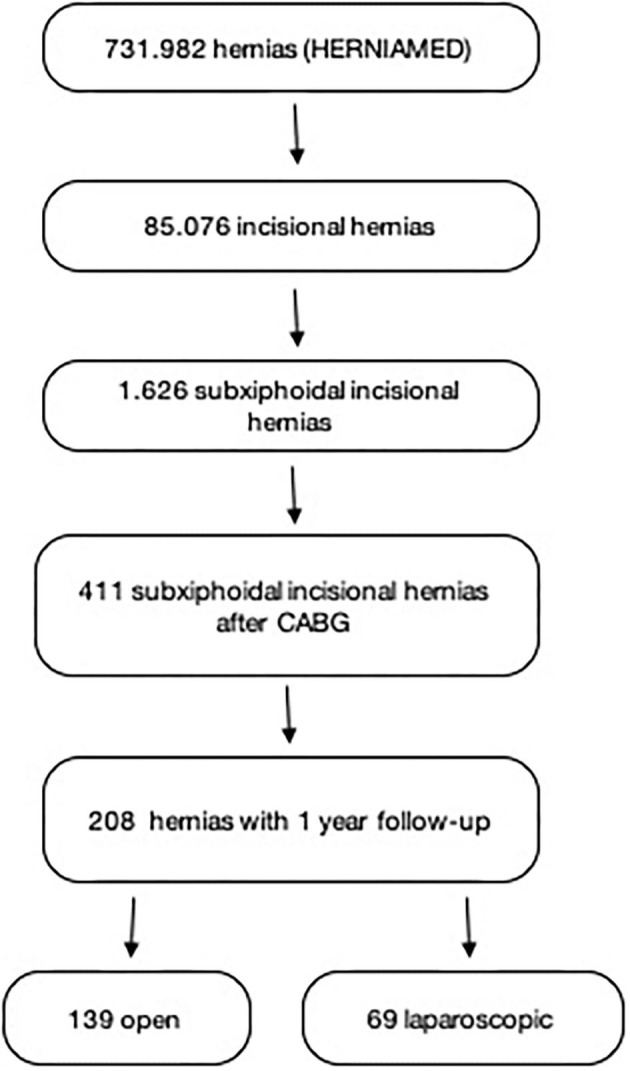
Flowchart of patient inclusion.